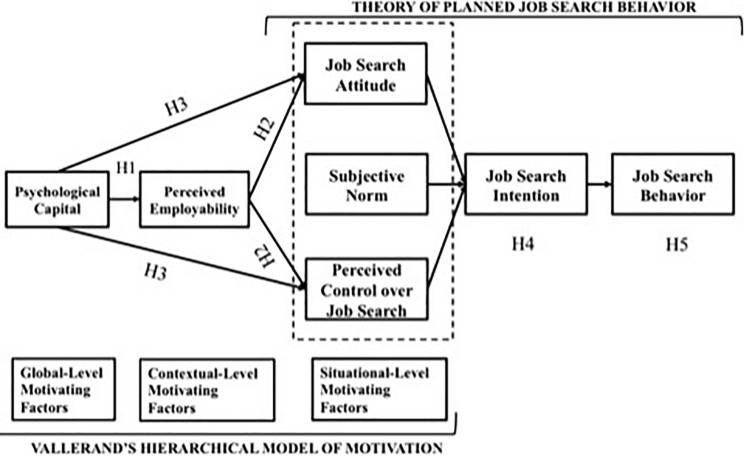
Conceptual model.